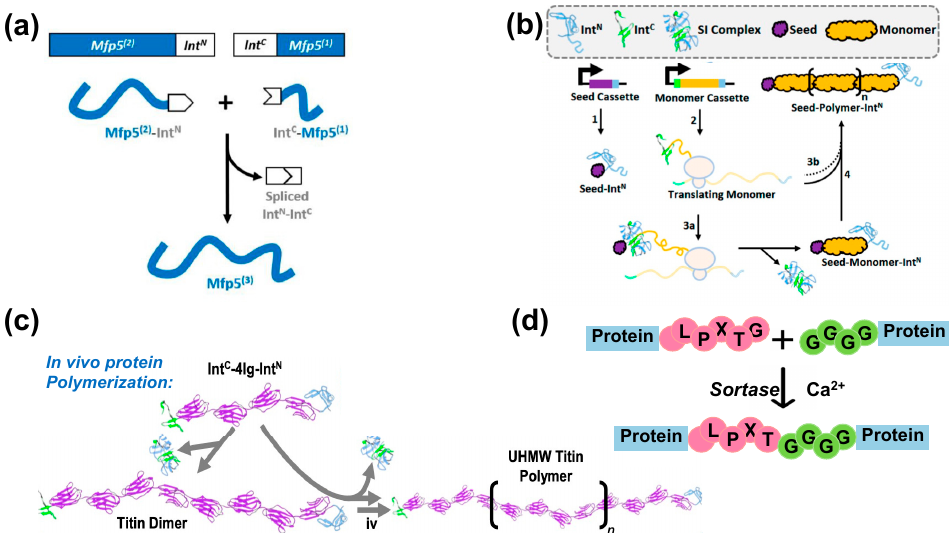
Figure 3. Different strategies for ligation of protein backbones via a peptide bond. ( a ) SI-mediated one-step protein–protein ligation of the mussel foot protein Mfp5 [2]. Copyright 2018, American Chemical Society. ( b ) SI-mediated chain growth protein polymerization [29]. Copyright 2019, American Chemical Society. ( c ) SI-mediated protein polymerization of titin Ig 67–70 [8]. Copyright 2021, Nature Publishing Group. ( d ) Sortase-mediated protein ligation reaction.